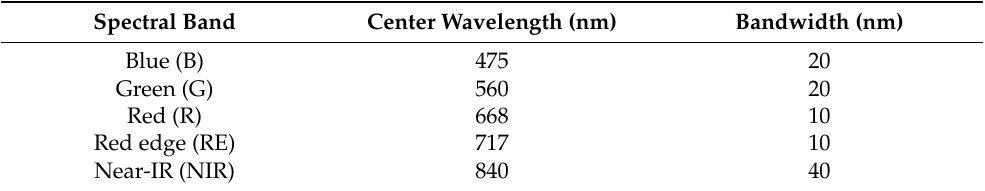
Table 2. Specifications of the RedEdge-M TM sensor from MicaSense ® .